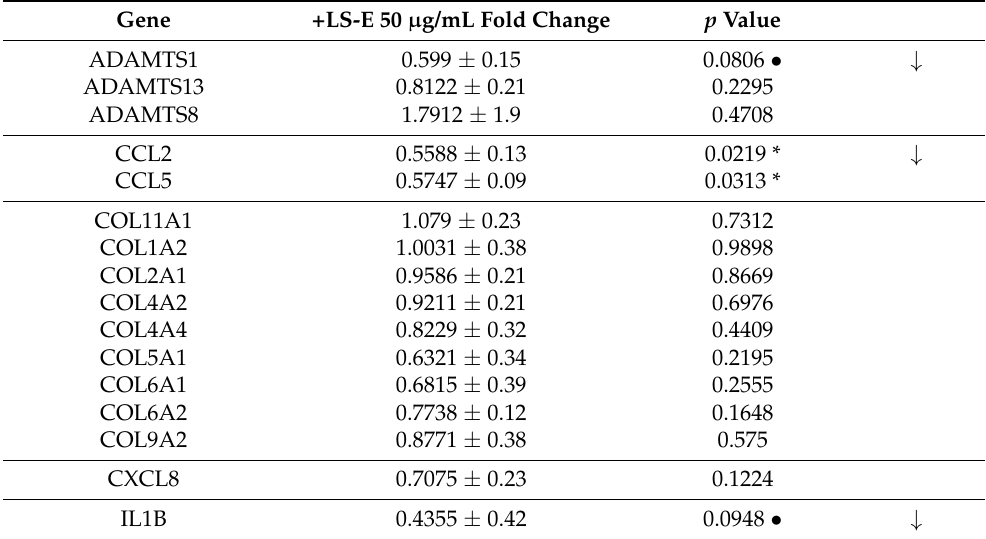
Table 1. Relative gene expression (expressed as fold change, mean ± standard error) of activated NHAC-kn in alginate beads, incubated with LS-E and IL1 β for 4 h (vs. control, cells incubated with IL1 β and without LS-E). n = 4. *: p ≤ 0.05, • : 0.1 > p > 0.05. ↓ : Decrease of gene expression with LS-E ( p < 0.1). Gene +LS-E 50 µ g/mL Fold Change p Value Gene ADAMTS1 0.599 ± 0.15